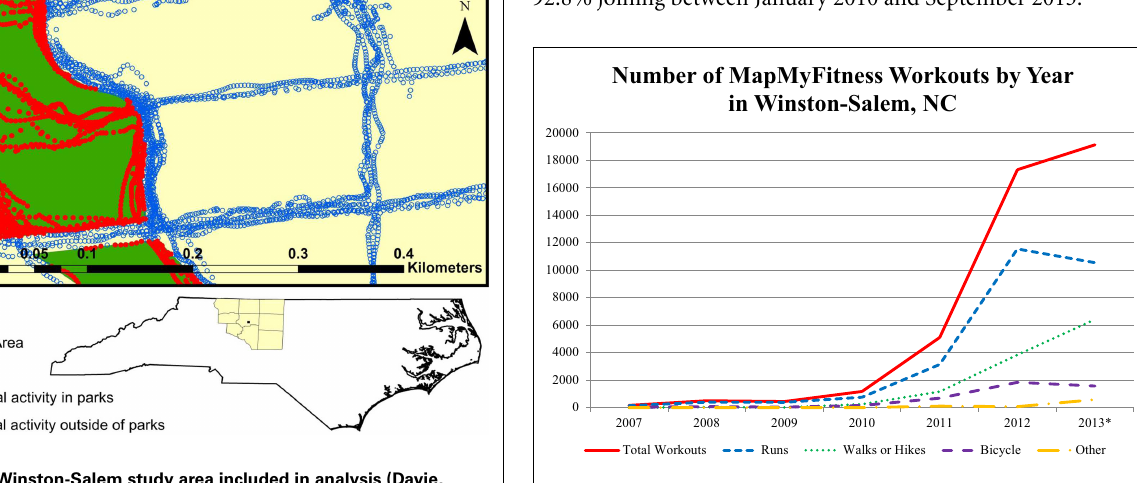
FIGURE 4 |Time-trends in MapMyFitness workout data for Winston-Salem, NC, USA by workout type . *Data for 2013 only represents January 1, 2013 through September 24,